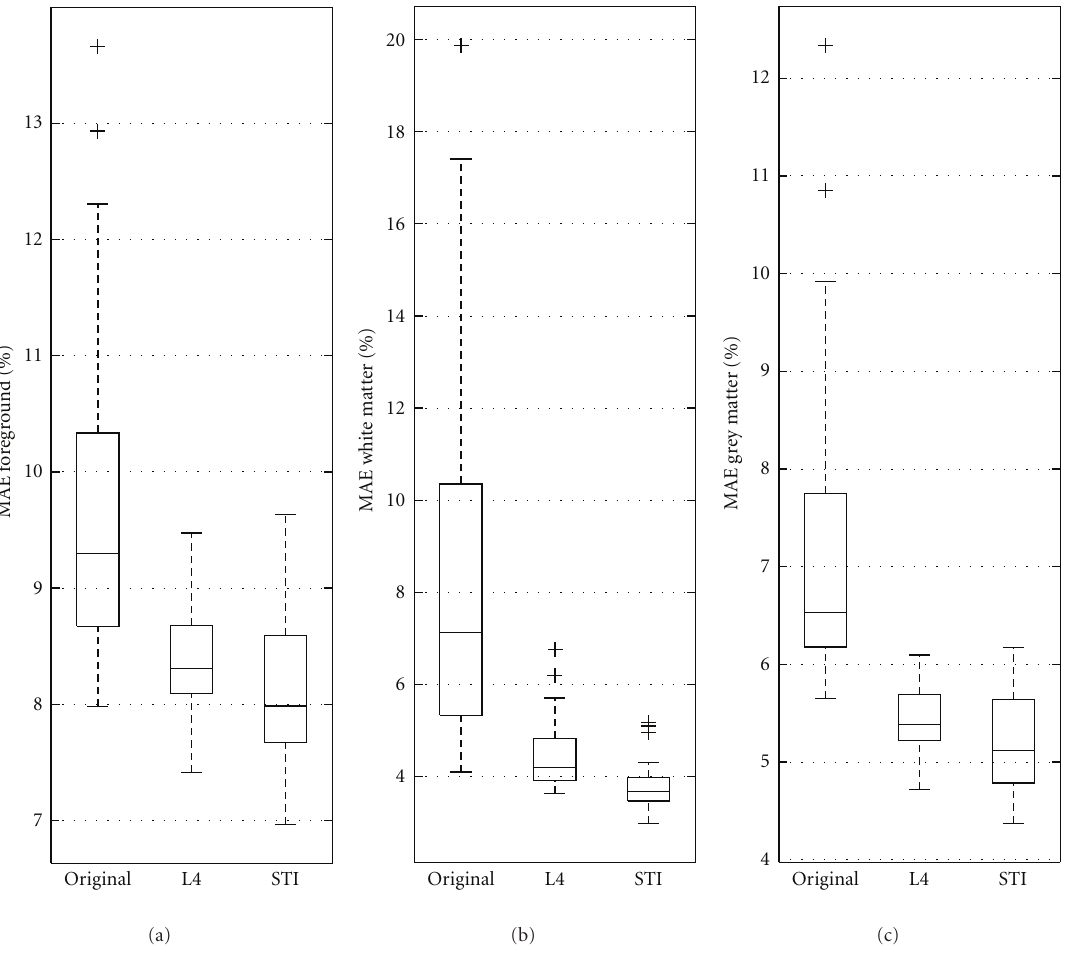
Figure 4: Boxplots of (a) FRG, (b) WM, and (c) GM mean absolute errors for the 21 images from Pilot E-ADNI. (Original) Nonlinearly registered input images, (L4) nonlinearly registered output images standardized with L 4 , and (STI) nonlinearly registered output images standardized with